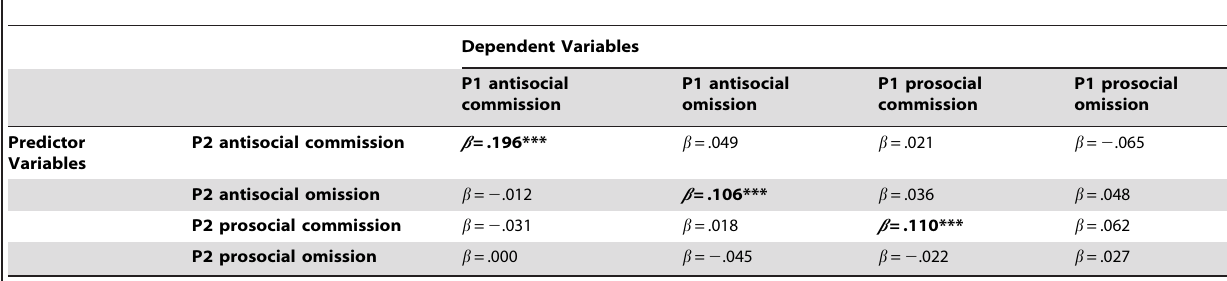
Table 2. Summary of Beta Values for Initial Regression